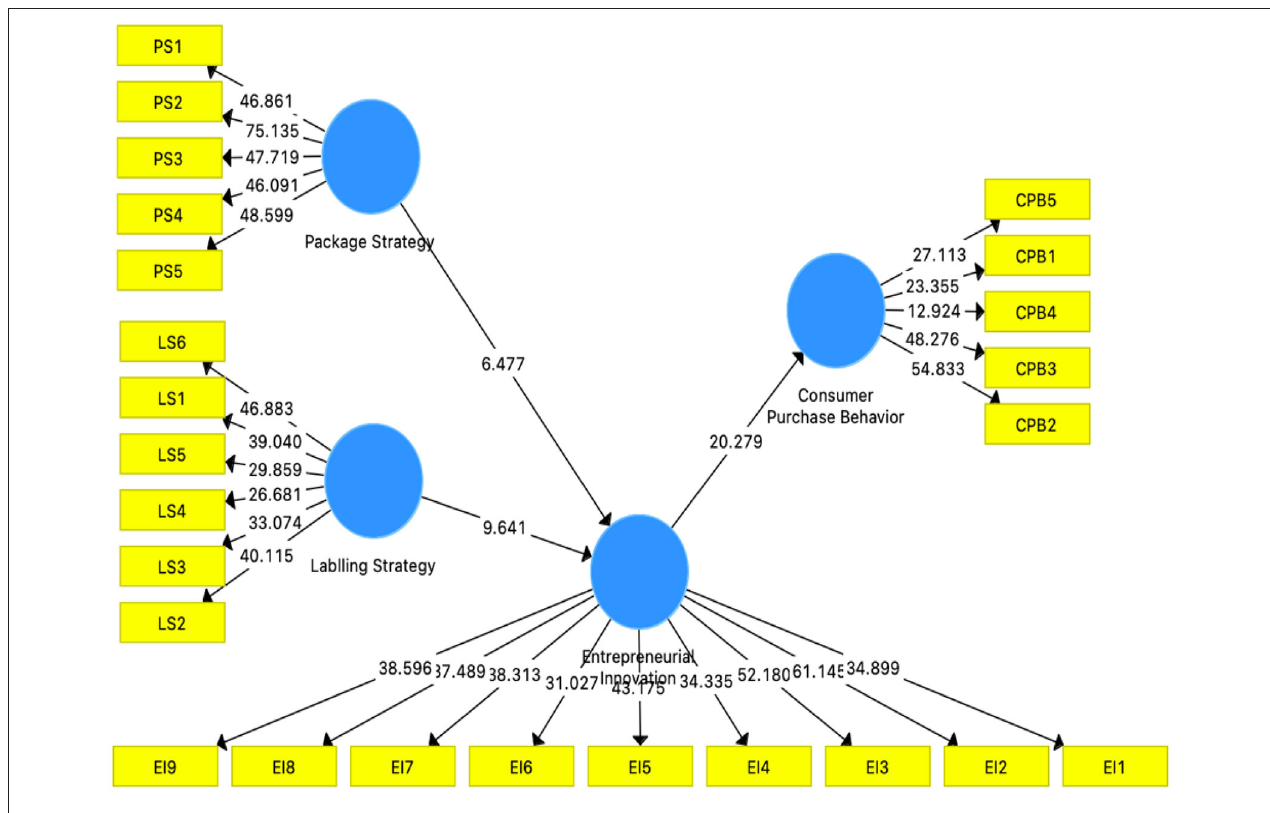
FIGURE 3 | Structural model results.